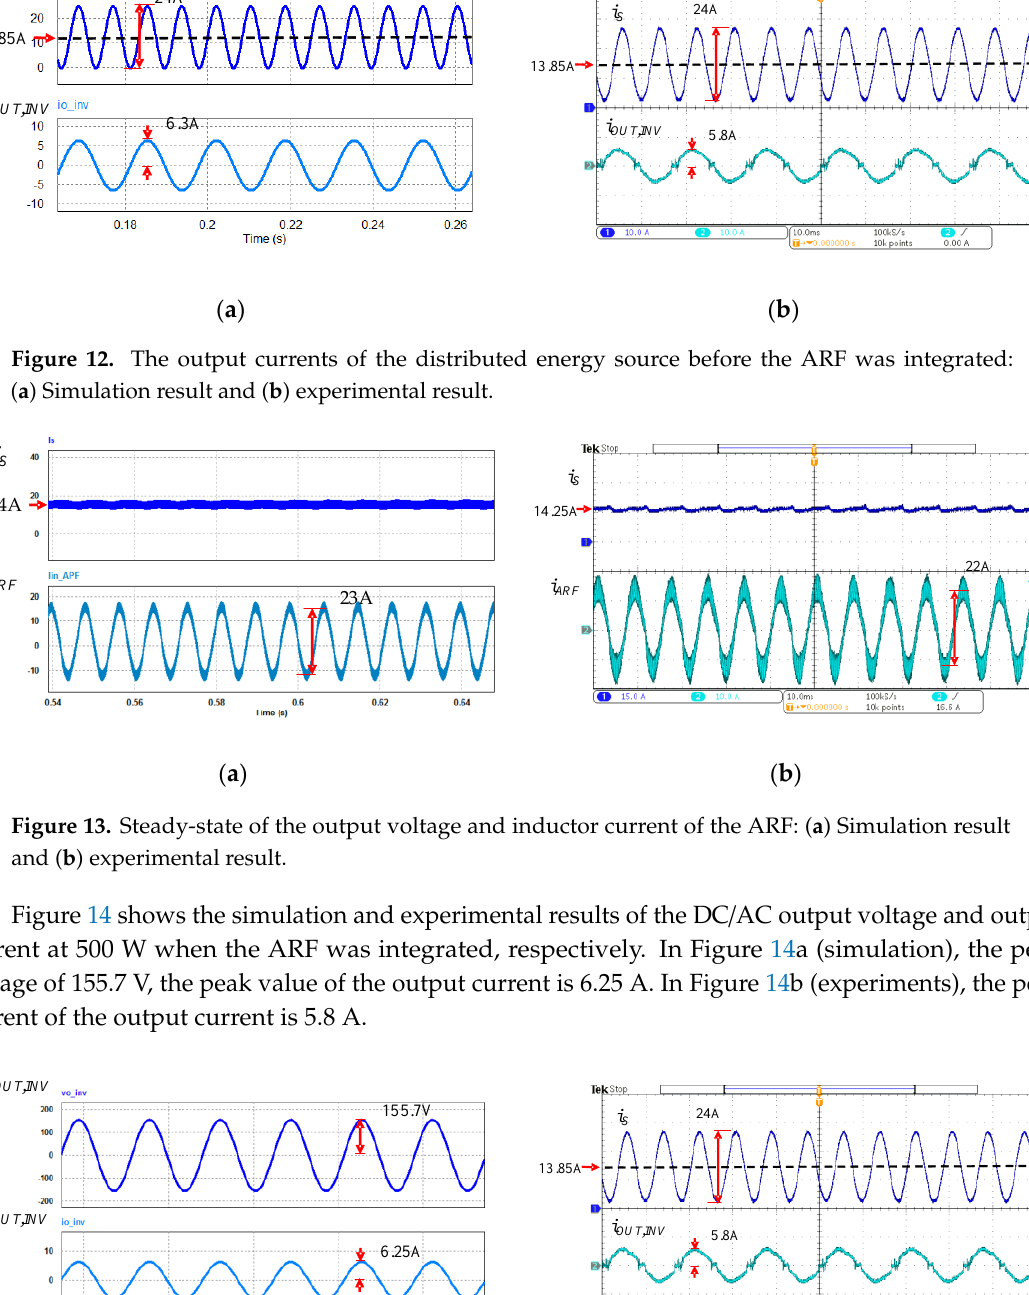
Figure 14. The output voltage and current of the proposed single-phase DC/AC conversion system. ( a ) Simulation result and ( b ) experimental result.